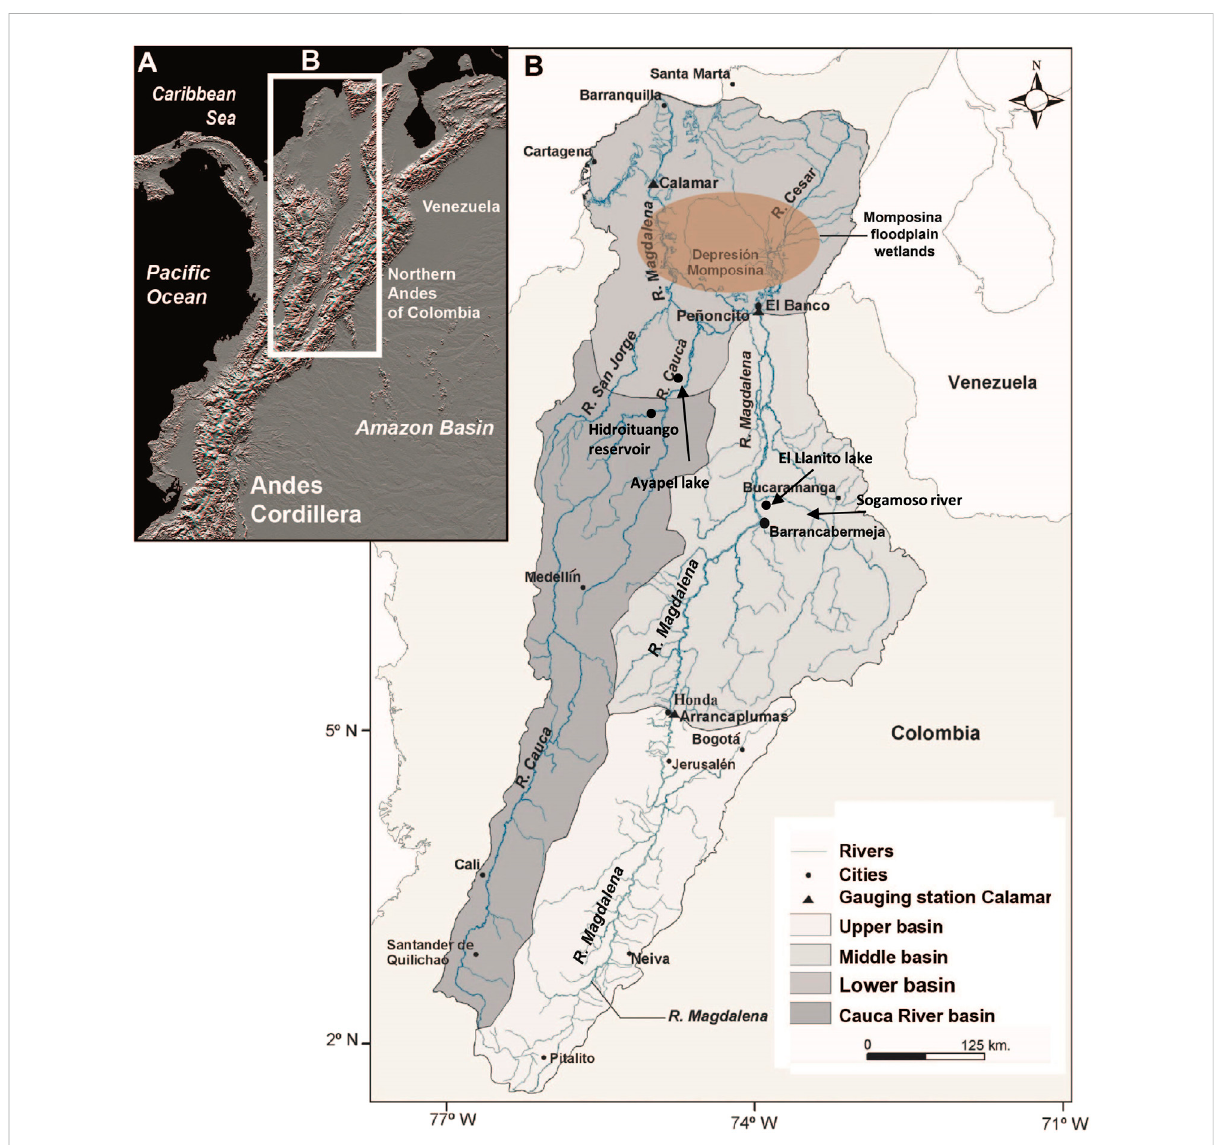
FIGURE 1 (A) Andes of Colombia, showing the location of the Magdalena River basin; (B) upper, middle, and lower sections of the catchment, and the most downstream fl oodplain wetlands, the Momposina, are also